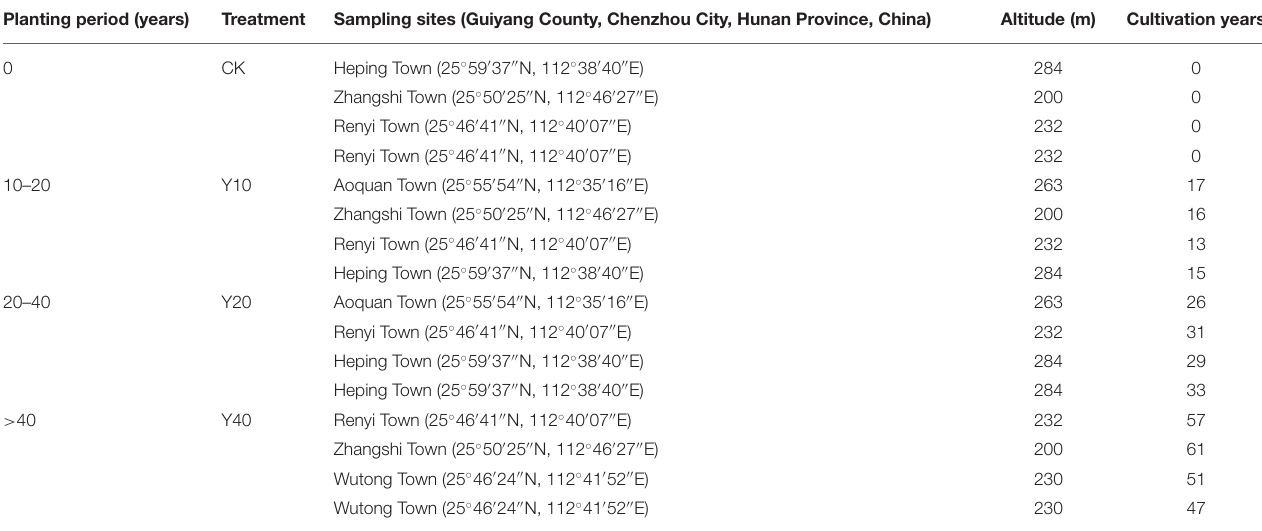
TABLE 1 | Sampling sites, altitude, and cultivation years of tobacco-rice multiple cropping rotation farmlands. Planting period (years)